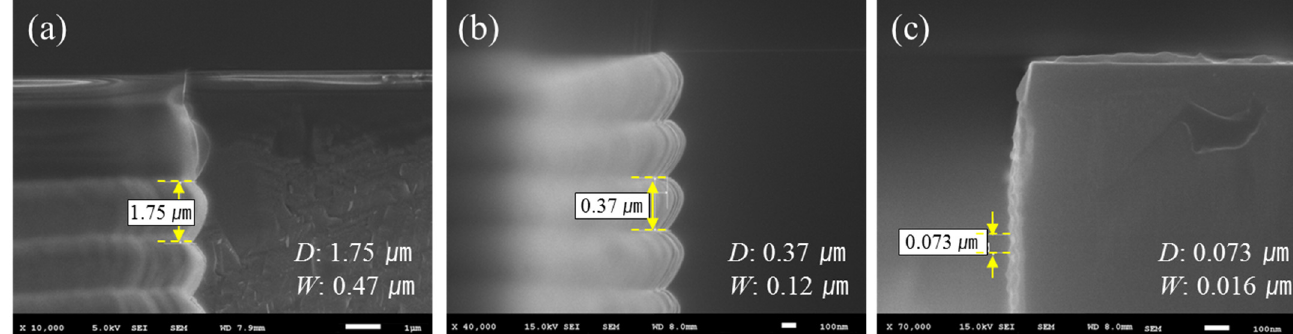
Figure 5. Cross sectional SEM image of the fabricated DRIE scallop. ( a ) Recipe 1, ( b ) recipe 2, and ( c ) recipe 3.